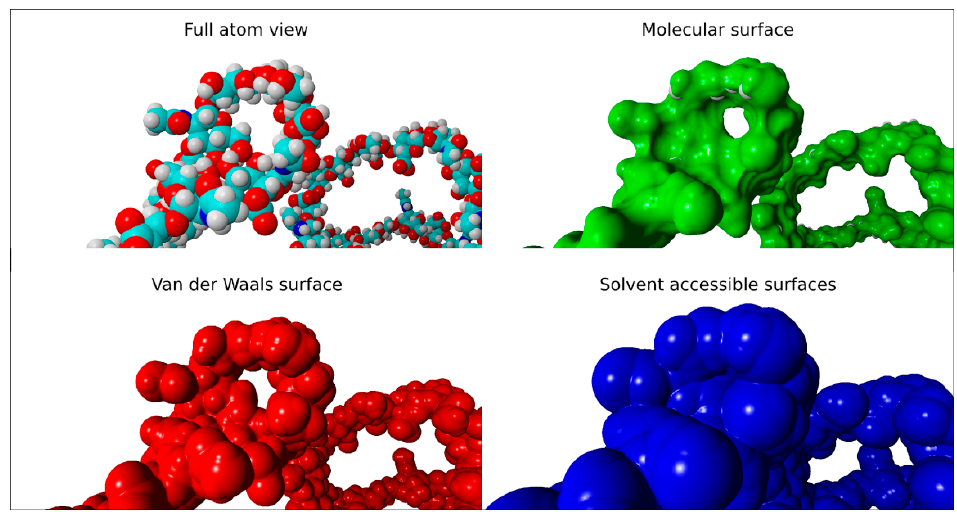
Figure 9. Full atom view of the hyaluronic acid molecule. The radius of water probe equals 1.4 Å. Red depicts oxygen; cyan, carbon; white, hydrogen; and blue, nitrogen.